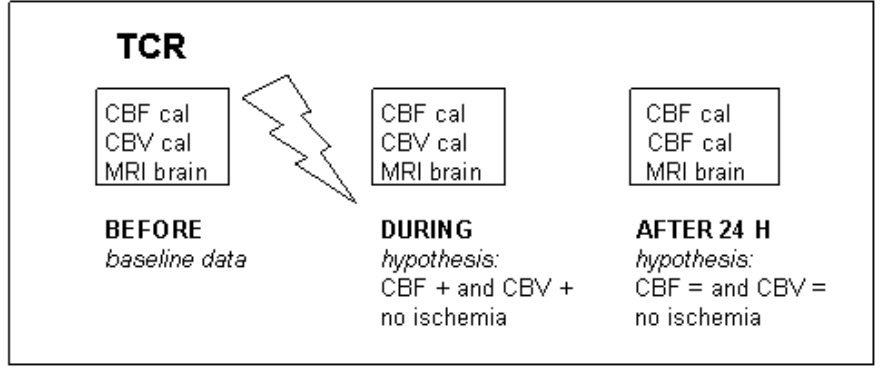
FIGURE 1 . Plan of the study protocol. CBF: cerebral blood flow; CBV: cerebral blood volume; MRI: magnetic resonance imaging; cal: calculated; +: increased to baseline data; =: unchanged to baseline